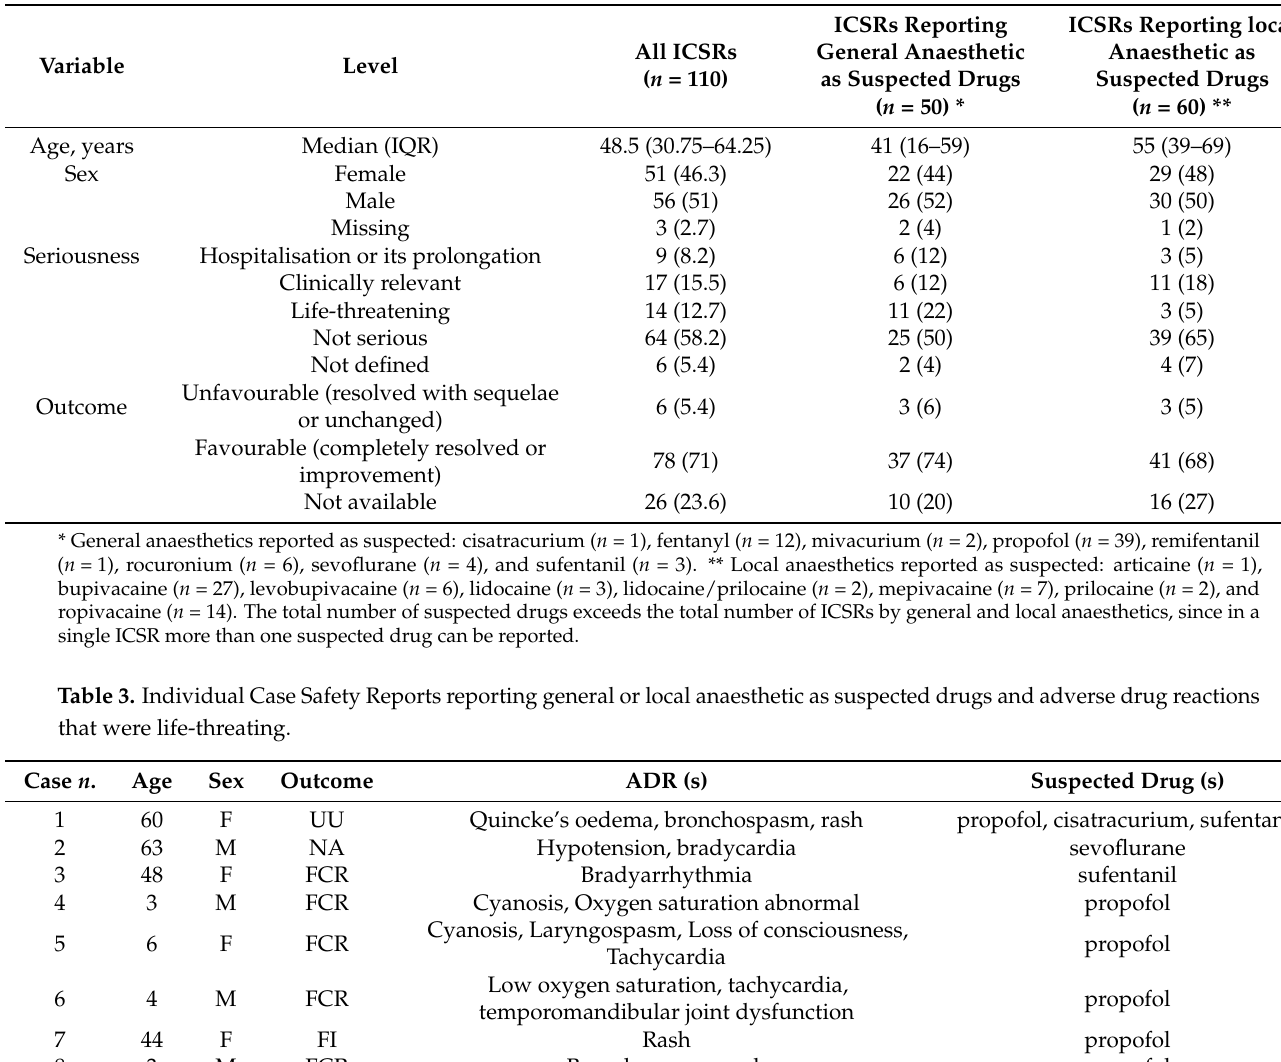
Table 2. Main characteristics of individual case safety reports which had general and local anaesthetic medicines as suspected drugs sent through the Campania region spontaneous reporting system, from January 2001 to September 2021.